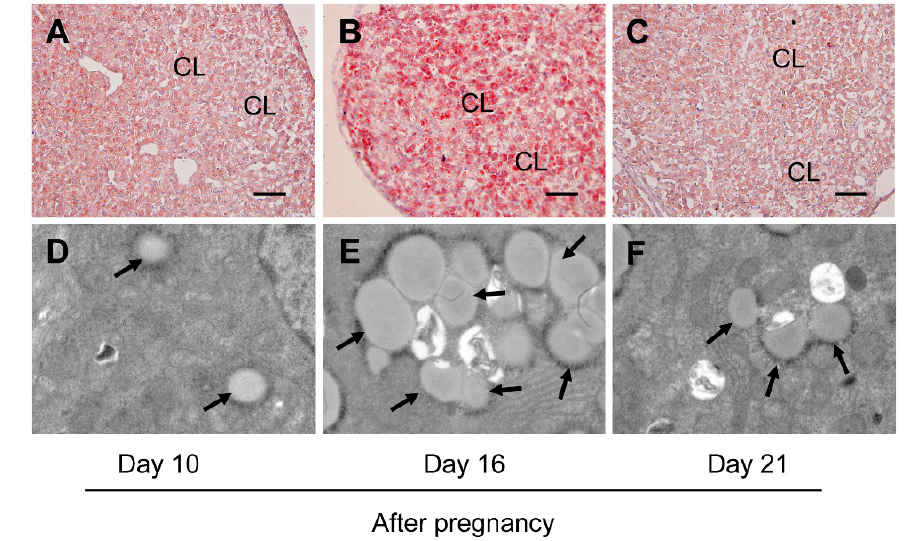
Figure 6. Changes of the storage of lipid droplets in ovaries during the luteal development of pregnant rats: ( A – C ) the storage of lipid droplets in CLs on days 10, 16, and 21 of pregnancy by Oil Red O staining, respectively; ( D – F ) the storage of lipid droplets in CLs on days 10, 16, and 21 of pregnancy by TEM observation, respectively. The arrows pointed to lipid droplets. CL: corpus luteum. Scale bar = 100 μ m.